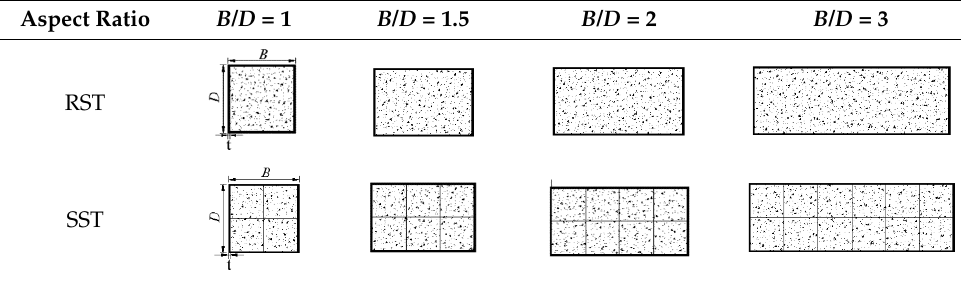
Table 1. Sectional forms of specimens.